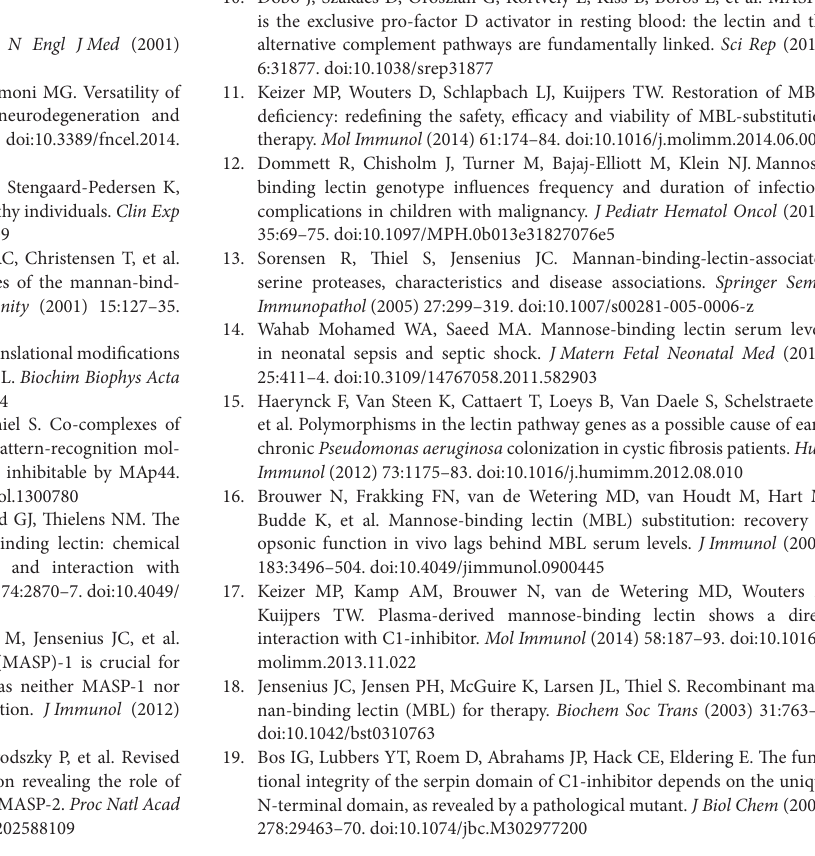
FigUre s1 | Specific monoclonal antibody (mAb) against MBL-associated serine protease (MASP)-2. Plates were directly coated with recombinant proteins, respectively, rMASP-1 ( ○ ), recombinant MASP-2 (rMASP-2) ( ■ ), and rMASP-3 ( □ ). Coated proteins were detected using a titration of specific biotinylated mAbs against MASP-1/3 (4H2A9) (36), against MASP-2 (12D12) or against MASP-3 (38:12-3) (36). (a) mAb 12D12 binds only to MASP-2 and does not show cross-reactivity toward the other serine protease. (B) mAb 4H2A9 is able to detect both MASP-1 and MASP-3 bound to the plate, by binding to a shared epitope (40). FigUre s2 | Reconstitution with recombinant MBL (rMBL) restores lectin pathway functionality. Plates were directly coated with mannan and a serum dilution of reconstituted mannan-binding lectin (MBL)-deficient serum with 50 μ g/ml rMBL ( ● ), MBL-deficient serum ( ○ ), or MBL-sufficient serum was tested for their C4-converting